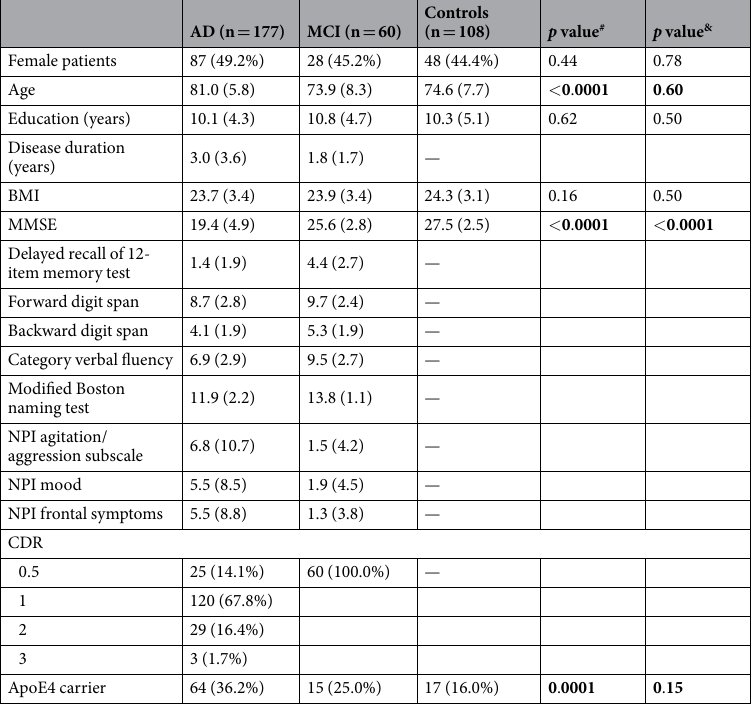
Table 1. Demographic and clinical data for the whole sample and patients with AD, MCI and controls. Values are means with standard deviations unless otherwise indicated. Values in boldface indicate statistically significant differences between groups. AD, Alzheimer’s dementia; MCI, mild cognitive impairment; BMI, body mass index; MMSE, Mini-Mental State Examination; NPI, Neuropsychiatric Inventory; CDR, clinical dementia rating. # Compare AD and controls by two-sample t-tests; $ compare MCI and controls by two-sample